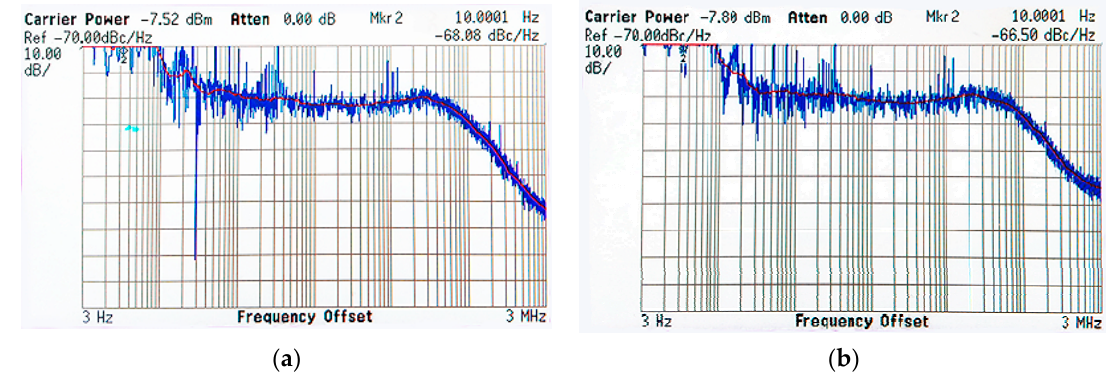
Figure 2. Ground assessment of Luojia-1A H1 ( a ) and H2 ( b ) signal phase noise.